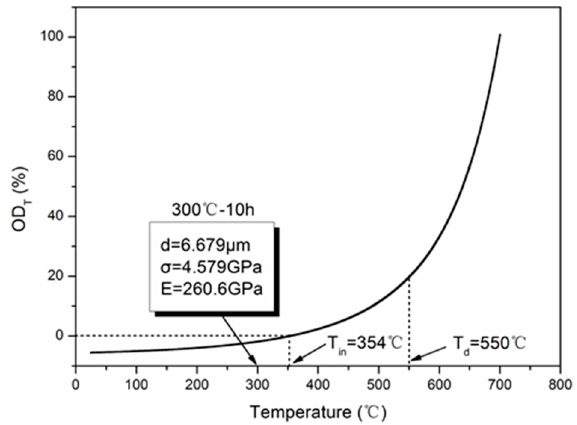
Figure 14. Variation of oxidation degree ( OD T ) versus the exposure temperature.